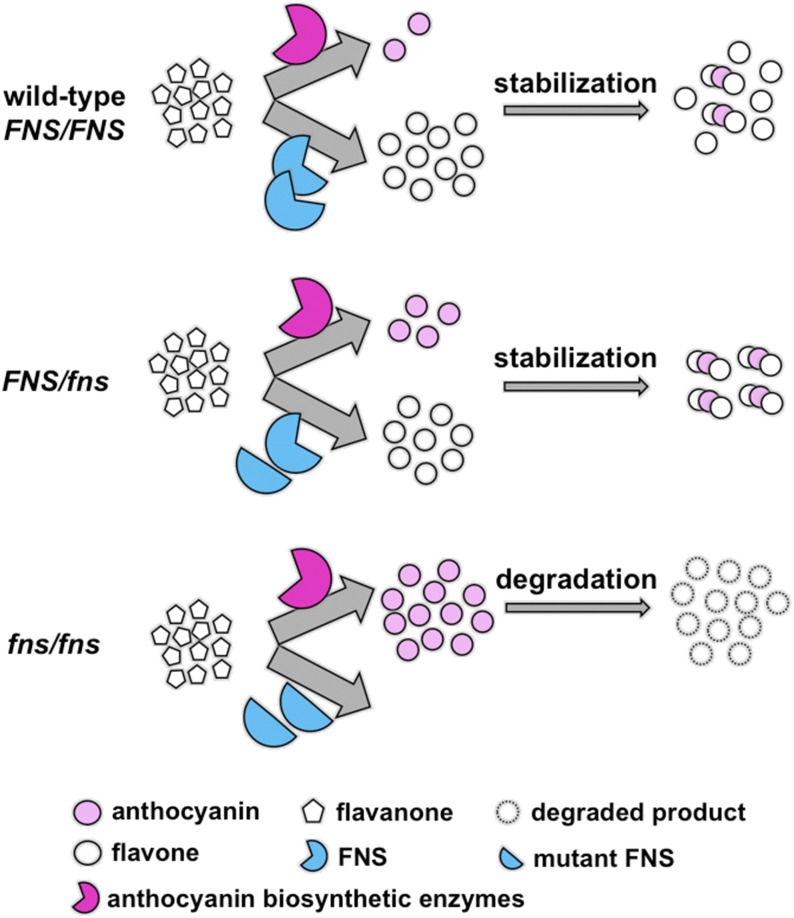
Schematic illustration of the antagonistic pleiotropic effects of the mutant FLAVONE SYNTHASE (FNS) allele in anthocyanin accumulation.